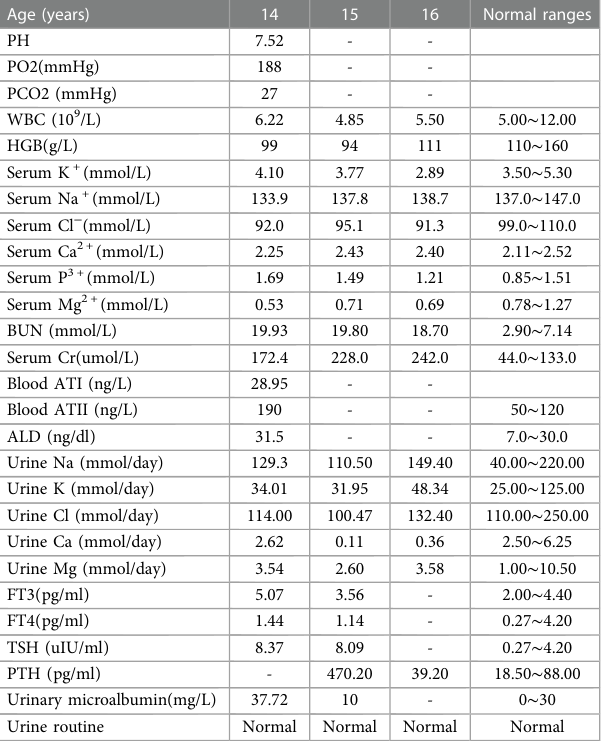
TABLE 1 The laboratory examinations of the